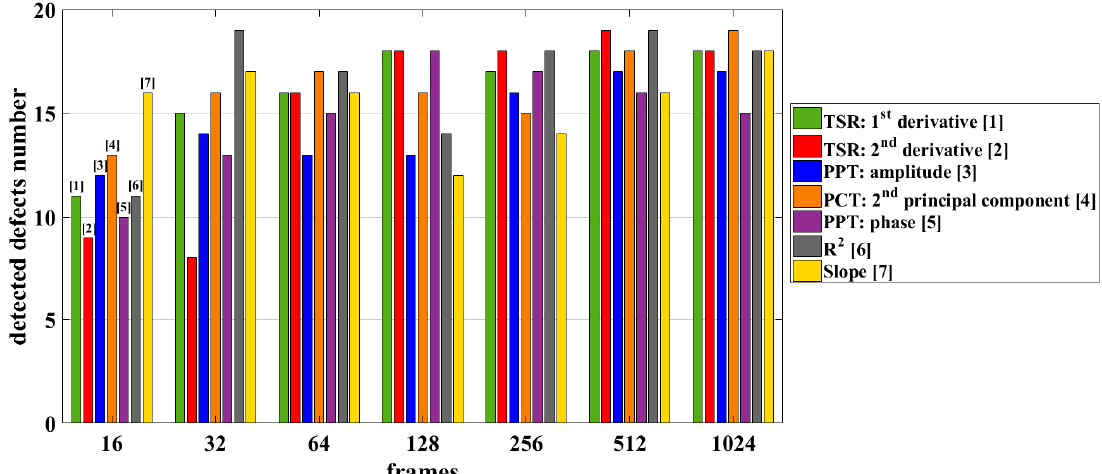
Figure 11. Comparison among the different algorithms in terms of the detected defects number for each interval in a bar plot.